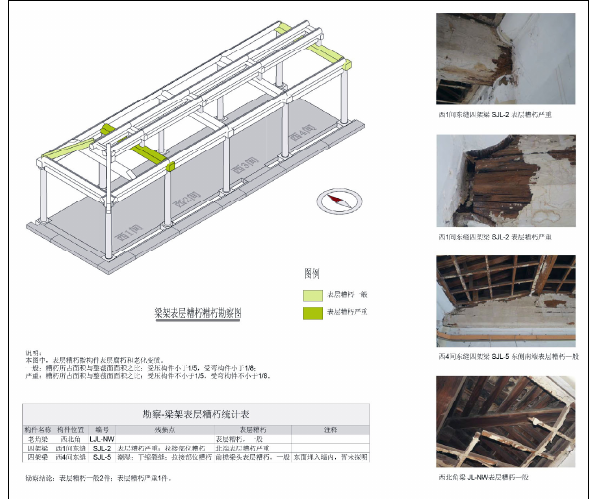
Figure 9 Example of thematic drawings; theme: surface rot of structural wood components